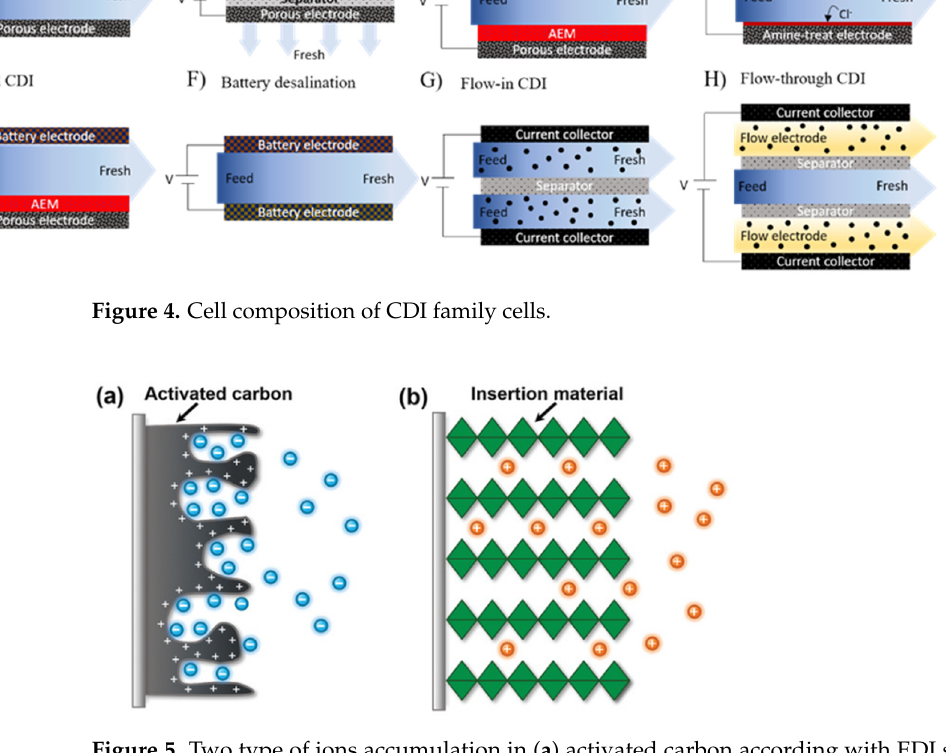
Figure 5. Two type of ions accumulation in ( a ) activated carbon according with EDLs mechanism and ( b ) intercalation and de-intercalation ions according with Faradaic reactions. Reprinted based on the open access license from [95].